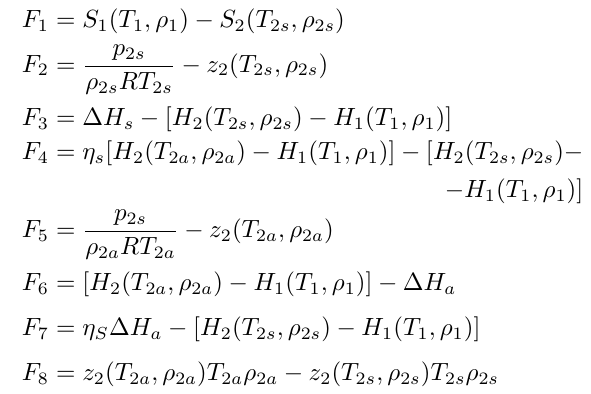
Table 3. Functions F